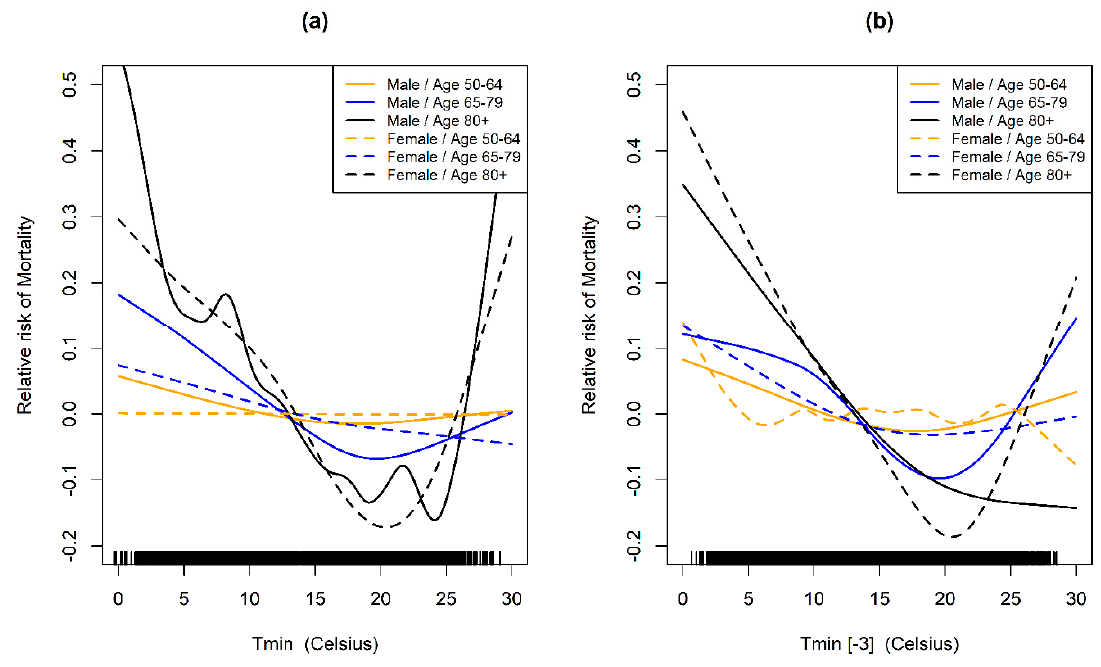
Figure 3. Mortality relative risk functions for Nicosia, Cyprus, 2007–2014 with ( a ) minimum temperature of the same day (T min ), ( b ) Weighted average minimum temperature of the preceding three days (T min[ – 3] ).